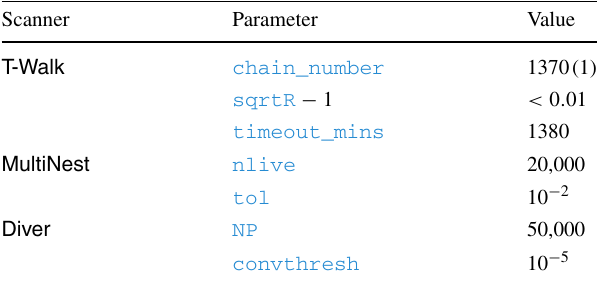
Table 5 Conversion criteria used for various scanning algorithms in both the full and low mass regimes. The chain_number chosen for T-Walk varies from scan to scan; we use the default T-Walk behaviour of chain_number = N MPI + N params + 1 on 1360 MPI processes. For more details, see Ref. [136]